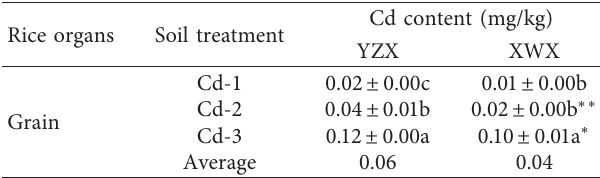
Table 5: Cd content in grain under soil treatment with different Cd concentrations. Rice organs